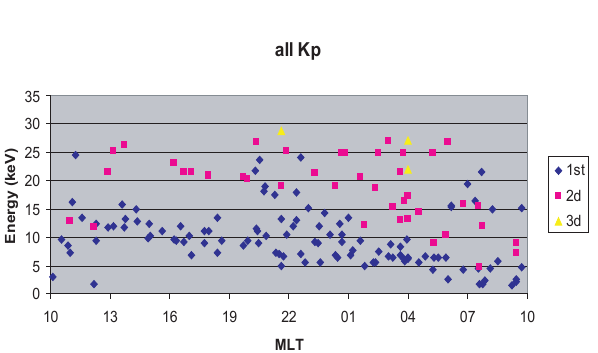
Fig. 7. Characteristic energy of each nose structure vs. MLT, for Figure 7 K p =0 and Fig. 6. Characteristic energy of each nose-like structure observed by Figure 6 CODIF, as a function of the MLT sector crossed by Cluster. Blue marks represent, when occurring, the nose observed at the lower energy range, whereas pink marks (resp. yellow) represent charac- teristic energies of the second (resp. third) nose-like structure.